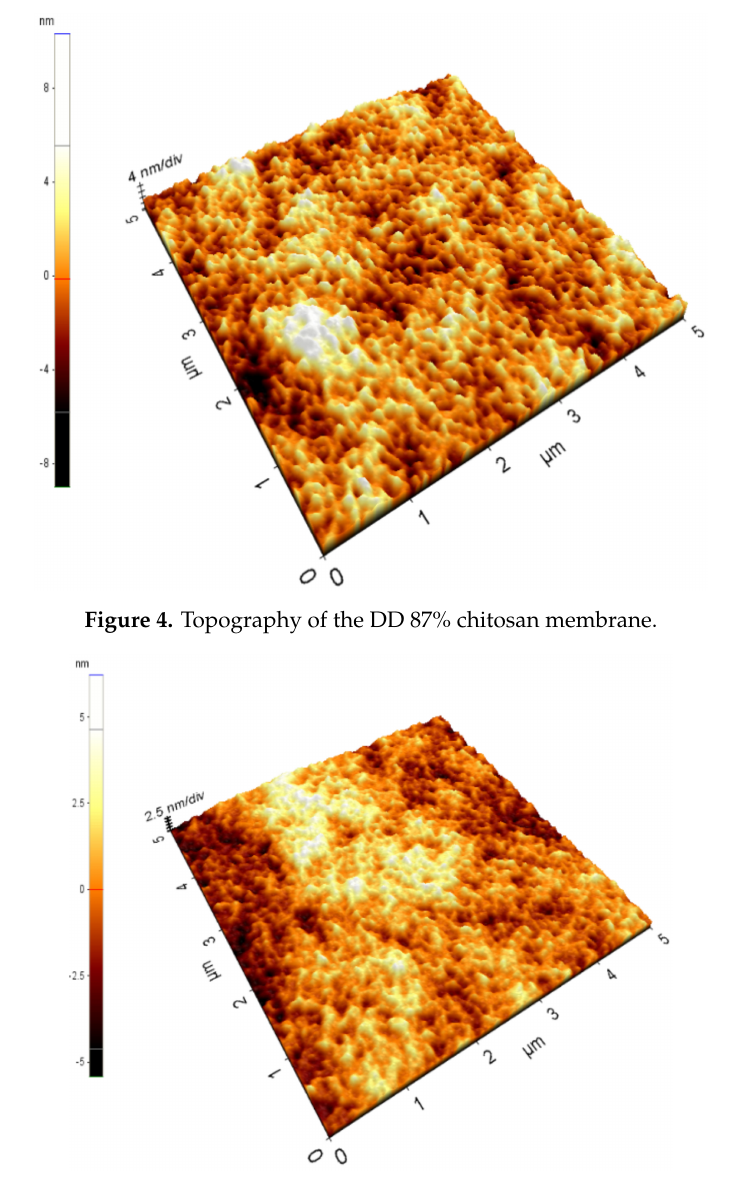
Figure 5. Topography of the DD 94% chitosan